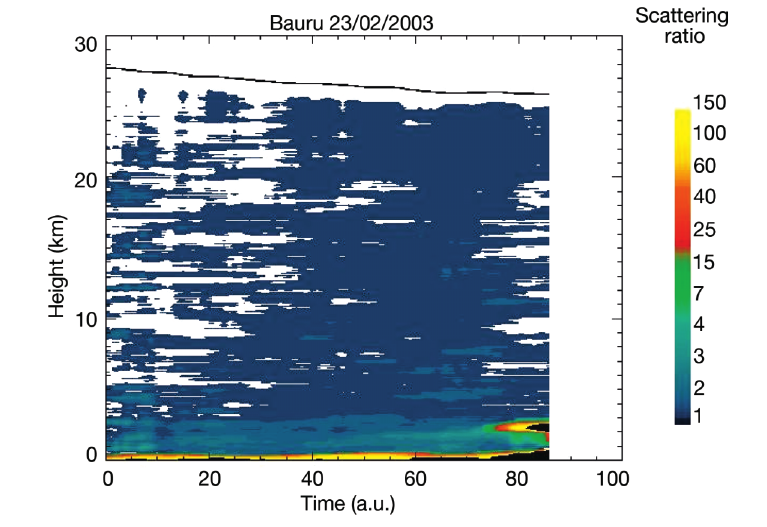
Fig. 4. MULID profile of backscattering ratio obtained in Brazil during a night time short duration flight. PBL is detected as a shallow area near the ground where scattering is above 1. A cloud is detected at the end of ac- quisition